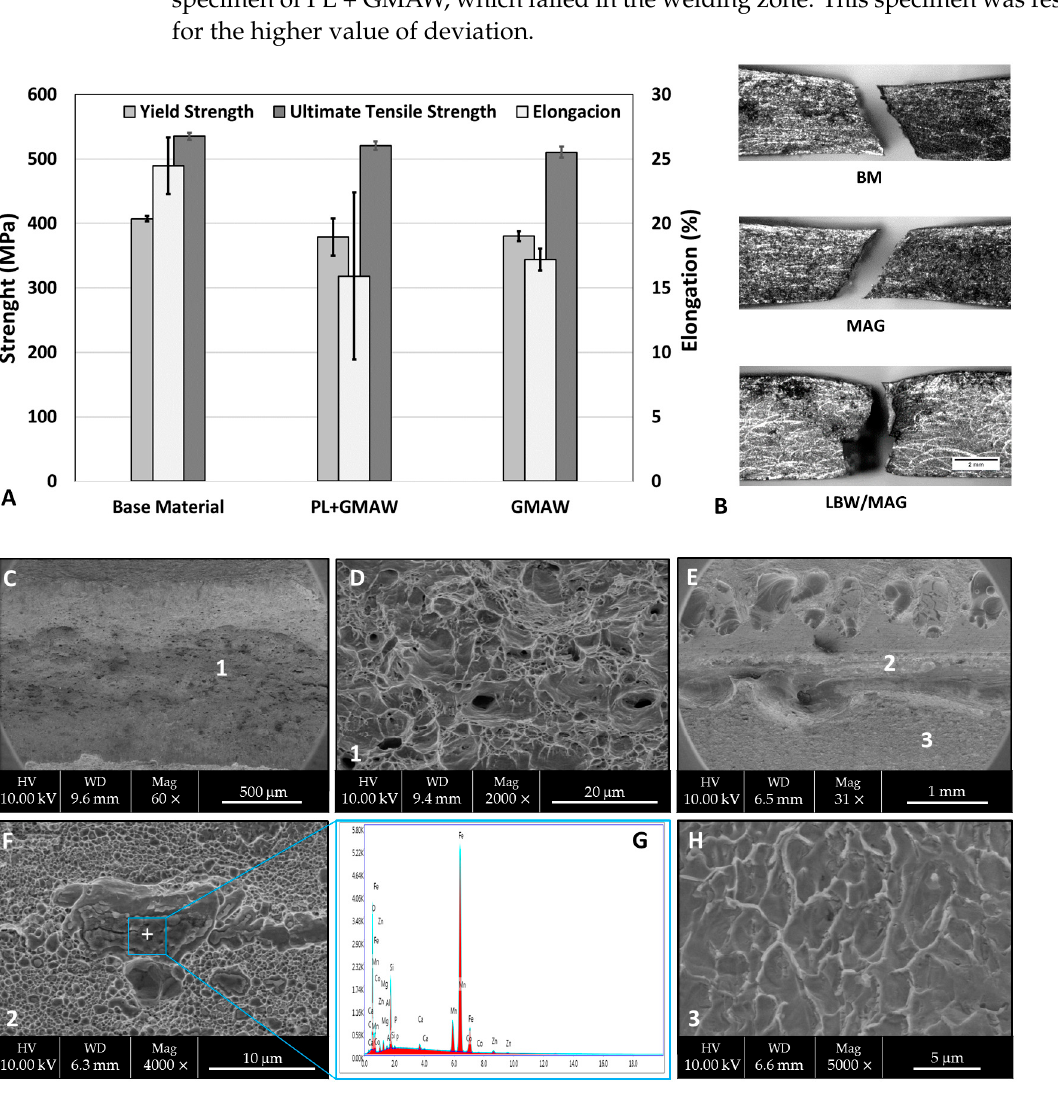
Figure 8. ( A ) Tensile properties of the base material and welded specimens. ( B ) Fractured specimens SEM images of fracture surface of the GMAW condition ( C , D ) and PL + GMAW condition ( E , F , H ). EDS spectrum of inclusion detected in PL + GMAW sample ( G ). EDS spectrum of inclusion detected in PL + GMAW sample ( G